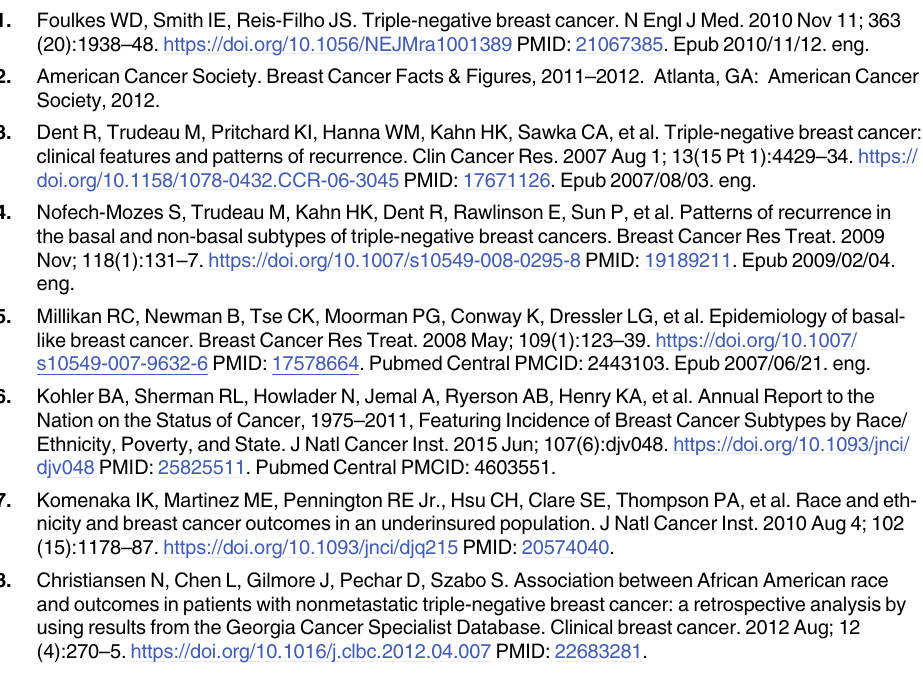
S1 Fig. Principal components analysis of batch effects in Detroit AA cohort. Plots of the first two principal components are shown pre- and post-standardization. Red dots correspond to batch 1 samples and black dots correspond to batch 2 samples. (TIFF) S2 Fig. Boxplots of CLCA2 , SPIC , and MIR4311 expression by batch. Boxplots of CLCA2, SPIC, and MIR4311 expression are shown by batch. The bold line within each boxplot repre- sents median expression, and the upper and lower bounds of the boxplot represent the 75th and 25th percentiles, respectively. Outer edges reflect the 10th (lower) and 90th (upper) per- centiles, respectively, and outliers are denoted in shaded circles.